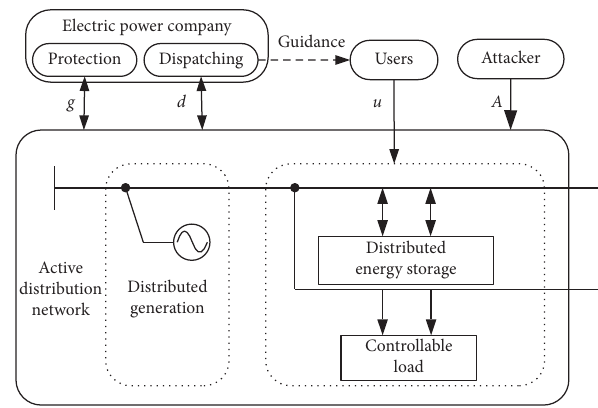
Figure 3: Distribution network control model with